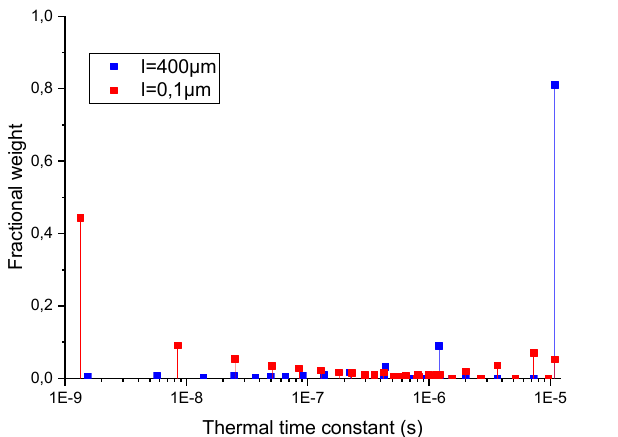
Figure 11. Thermal time constant spectrum for 2-D structure using MOR in black and Bagnall equation in red.